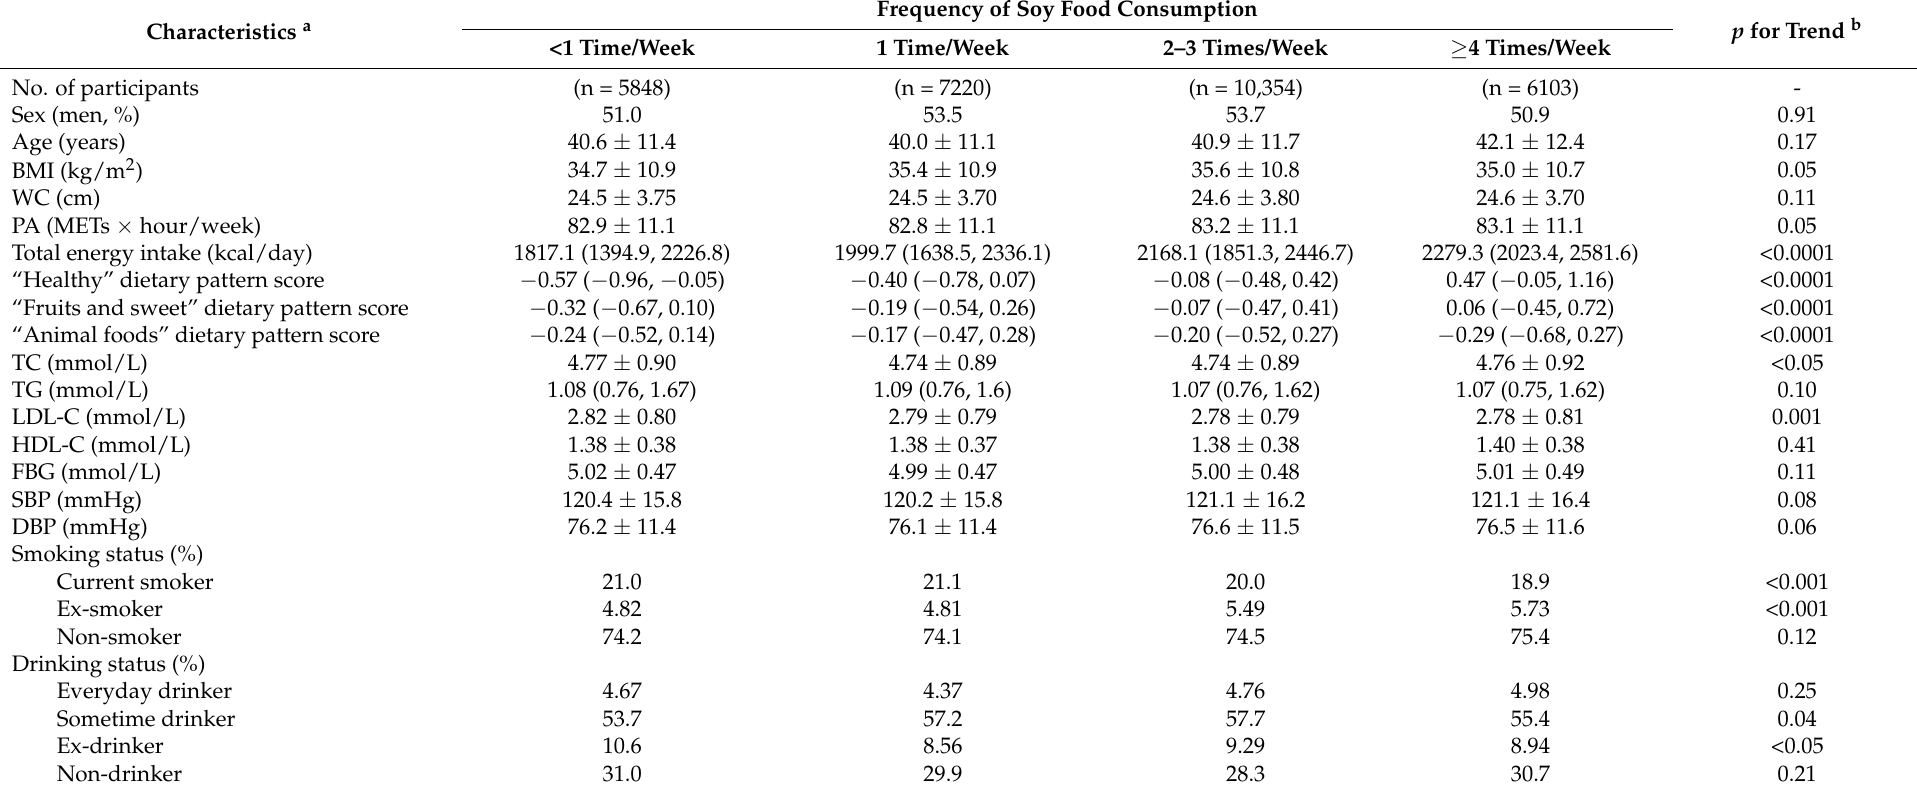
Table 1. Baseline characteristics of the participants according to frequency of soy food consumption (n =